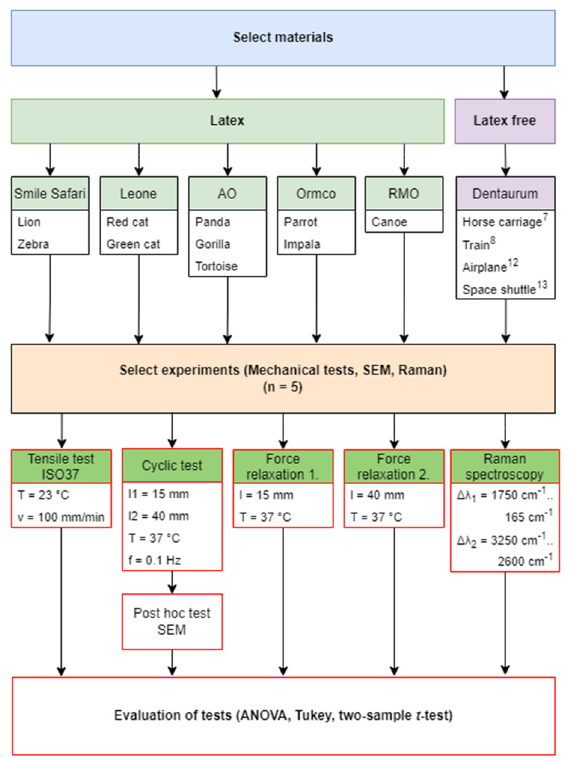
Figure 1. The protocol of the study. 7,8,12,13 The name of the elastomers.